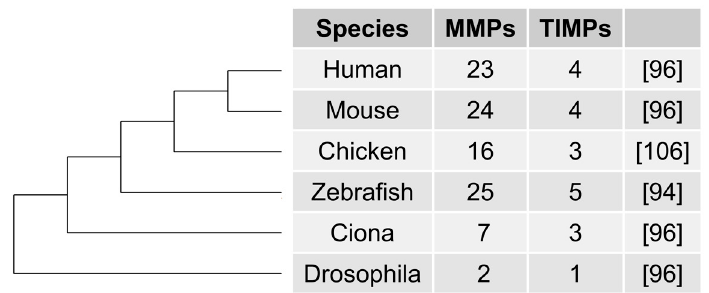
Figure 1. Matrix metalloproteinase (MMP) and tissue inhibitor of matrix metalloproteinase (TIMP) representation across common model species from the literature.